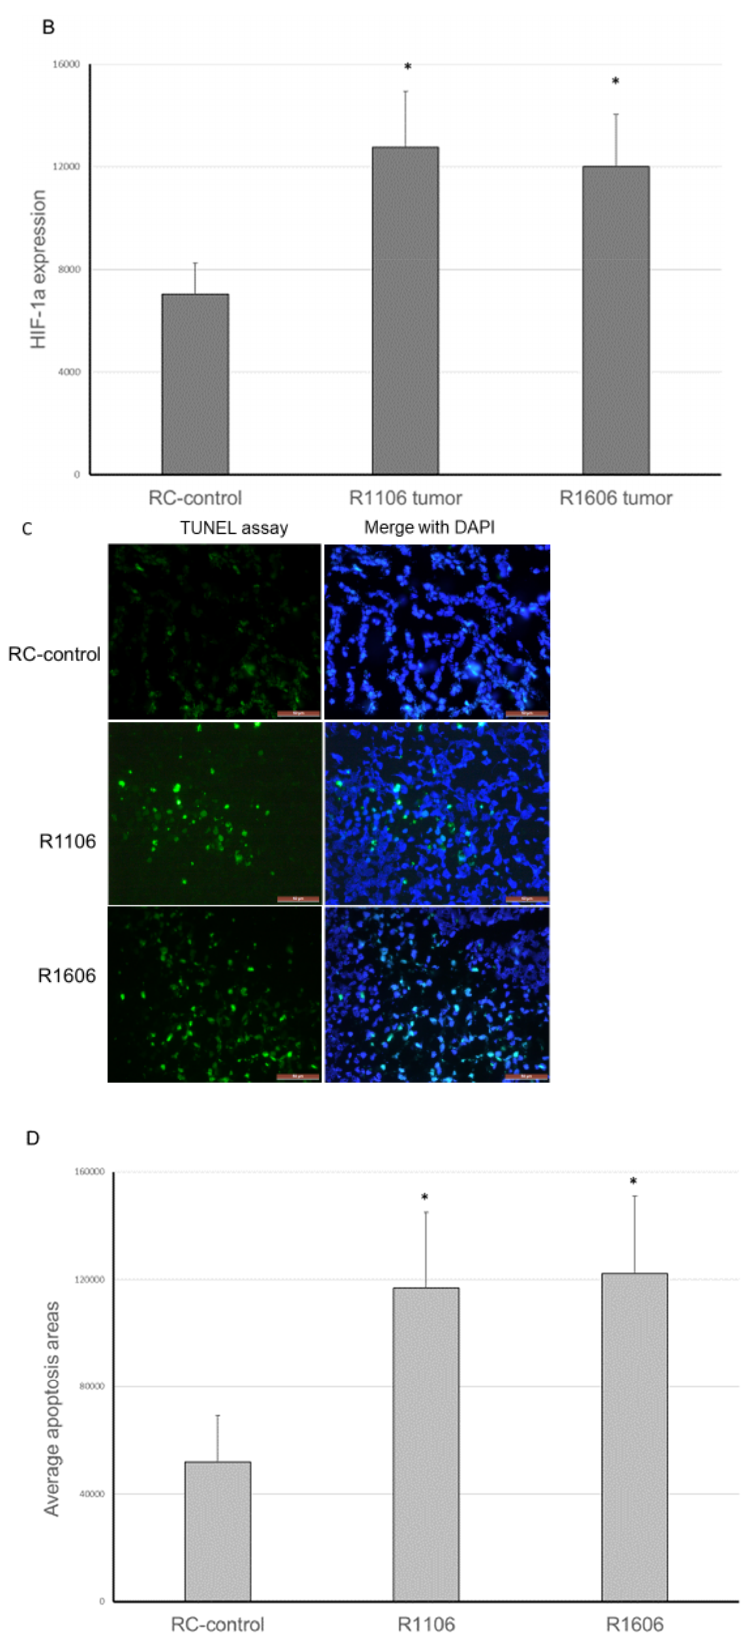
Figure 6. REST-KO increased tumor hypoxia and apoptosis. ( A ) Hypoxia marker HIF-1 α expression Figure 6. REST ‐ KO increased tumor hypoxia and apoptosis. ( A ) Hypoxia marker HIF ‐ 1 α expression was detected by immunofluorescence staining (scale bar: 100 µ m). ( B ) The average HIF-1 α was detected by immunofluorescence staining (scale bar: 100 μ m). ( B ) The average HIF ‐ 1 α expression was quantified by assessment of five random fields in each group. Bars represent standard deviation. * p < 0.05. ( C ) TUNEL assay was performed to detect apoptosis (scale bar: 50 μ m), and ( D ) the average apoptosis area was quantified by assessment of five random fields per group. Apoptotic cells were significantly increased in R1106 and R1606 REST ‐ KO tumors compared with RC ‐ control tumors. Bars represent standard deviation. * p < 0.05.